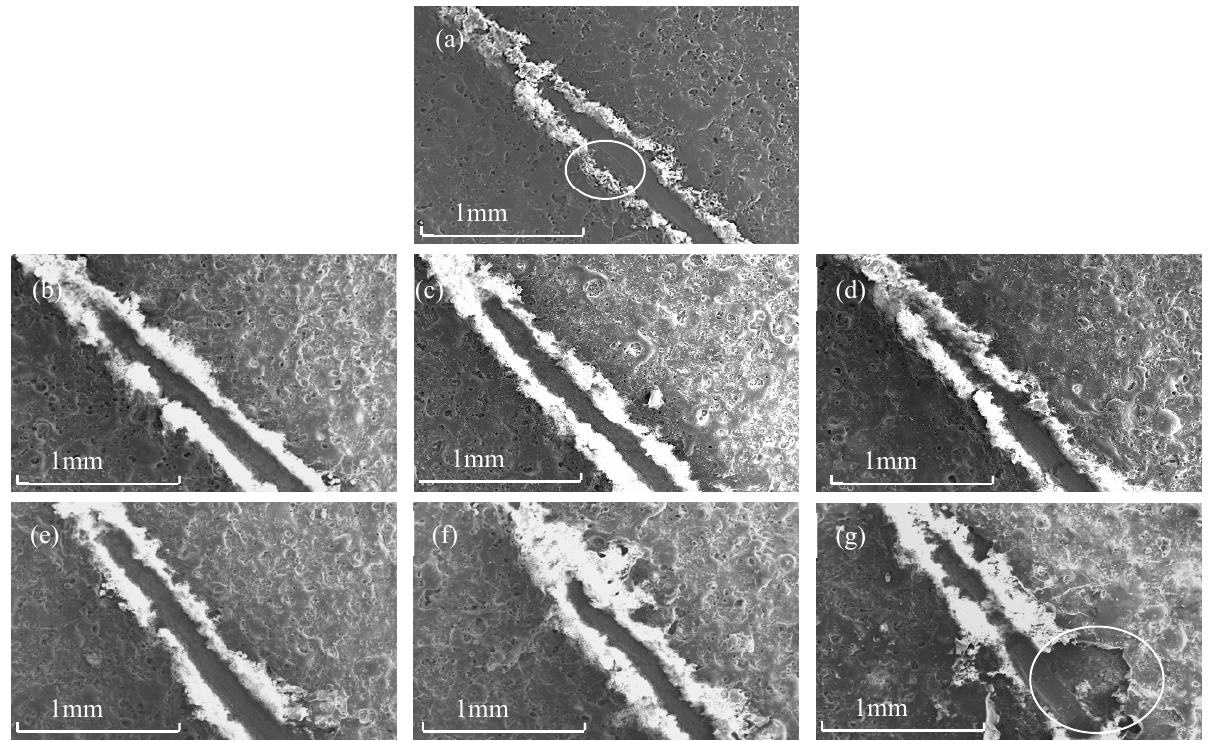
Figure 7. Scratch morphology of MAO coating: ( a ) S0; ( b ) S1; ( c ) S2; ( d ) S3; ( e ) S4; ( f ) S5; and ( g ) S6.